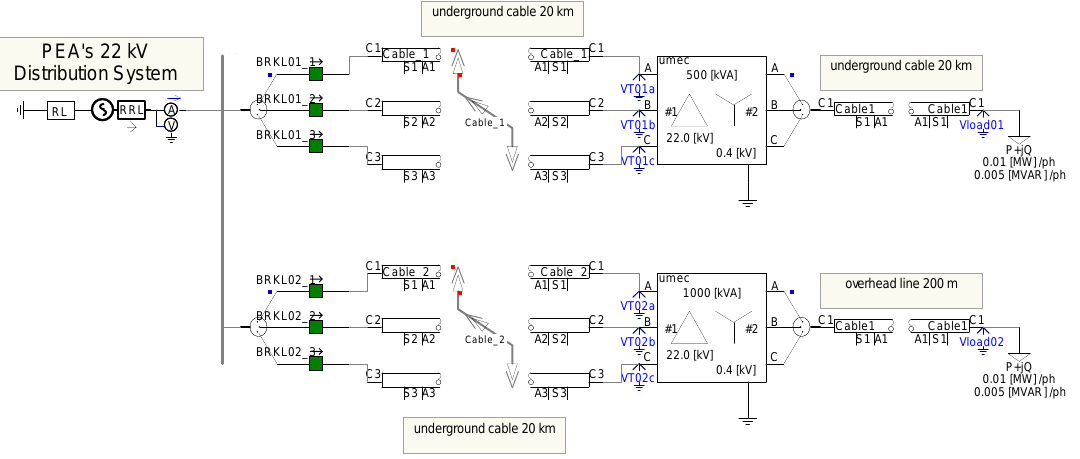
Figure 9. The single line diagram of the 1 MVA and 500 kVA transformer connections.